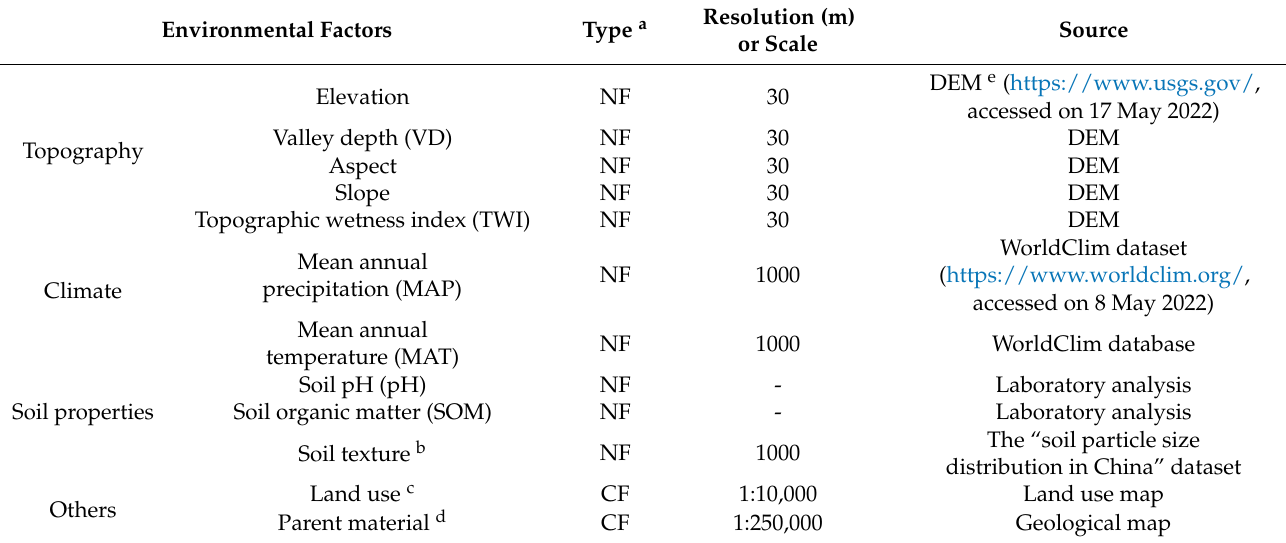
Table 1. The information on environmental